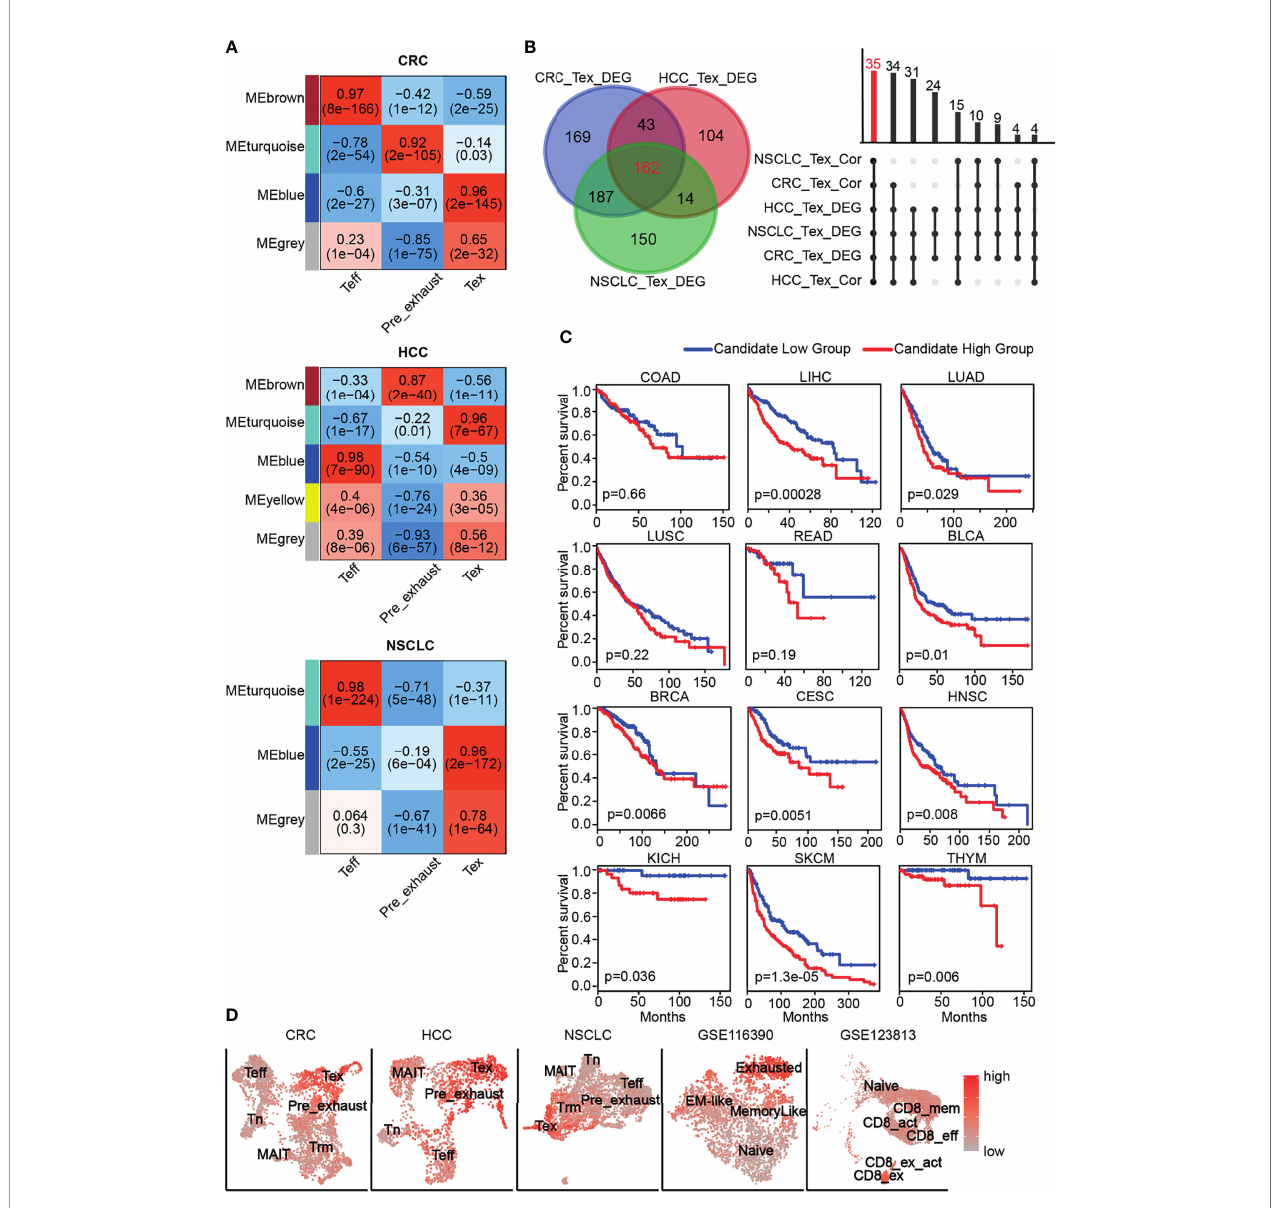
FIGURE 2 | Candidate gene set associated with CD8+ Tex cells. (A) The gene coexpression network modules of CD8+ T cells with correlation coef fi cient and p - value. (B) The number of genes with differential expression (left) and coexpression (right). (C) The Kaplan-Meier overall survival curves of TCGA patients grouped by the middle expression value of Candidate gene set. The red and blue lines denote higher and lower expression group, respectively. (D) Distinguishing Tex cells from the other CD8+ T cells effectively in different cancers by GSVA score of Candidate gene